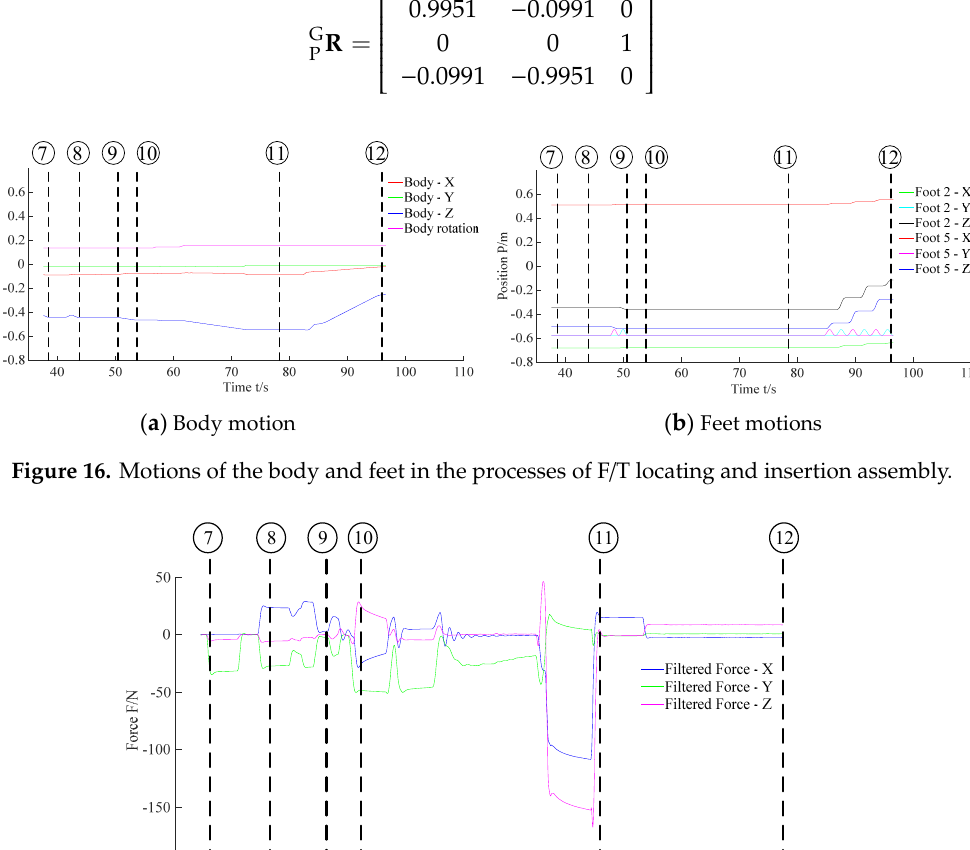
Figure 16. Motions of the body and feet in the processes of F/T locating and insertion assembly.